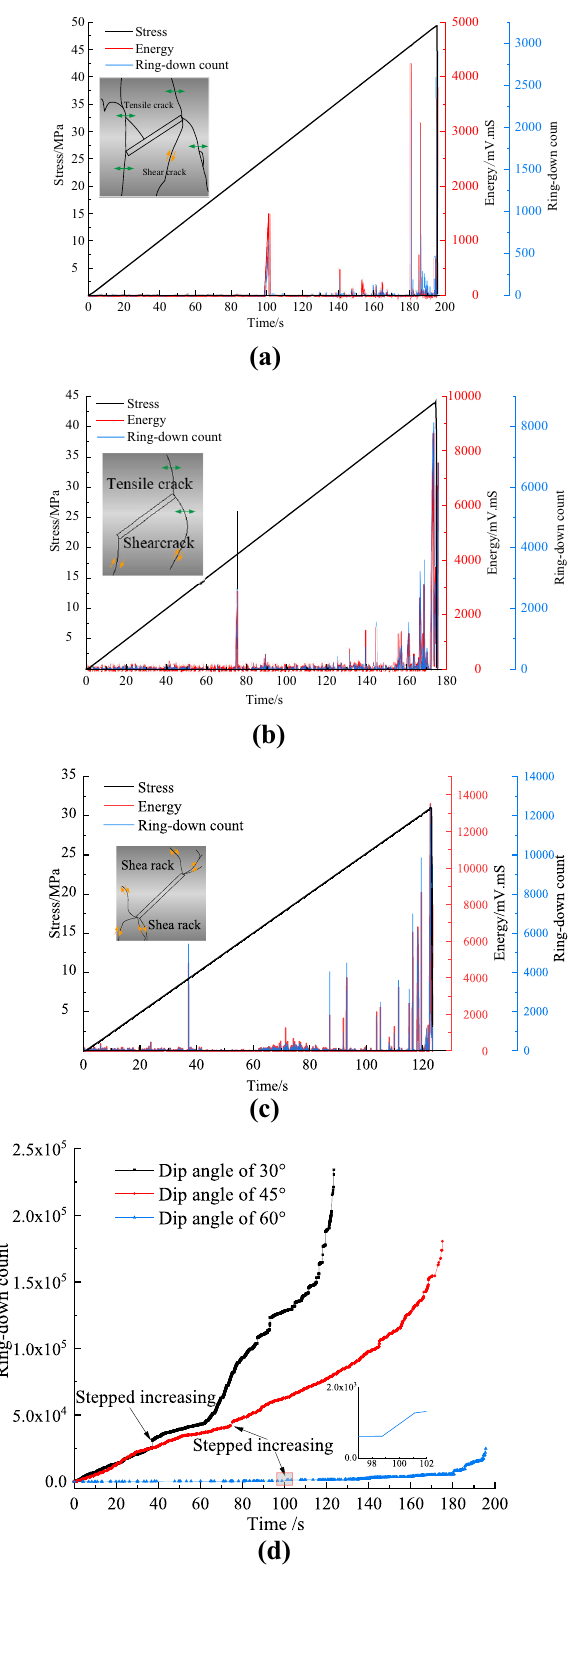
b Fig. 8 Acoustic emission (AE) features of precracked rock speci- mens: a crack dip angle of 60 (cid:3) ; b crack dip angle of 45 (cid:3) ; c crack dip angle of 30 (cid:3) ; d cumulative AE